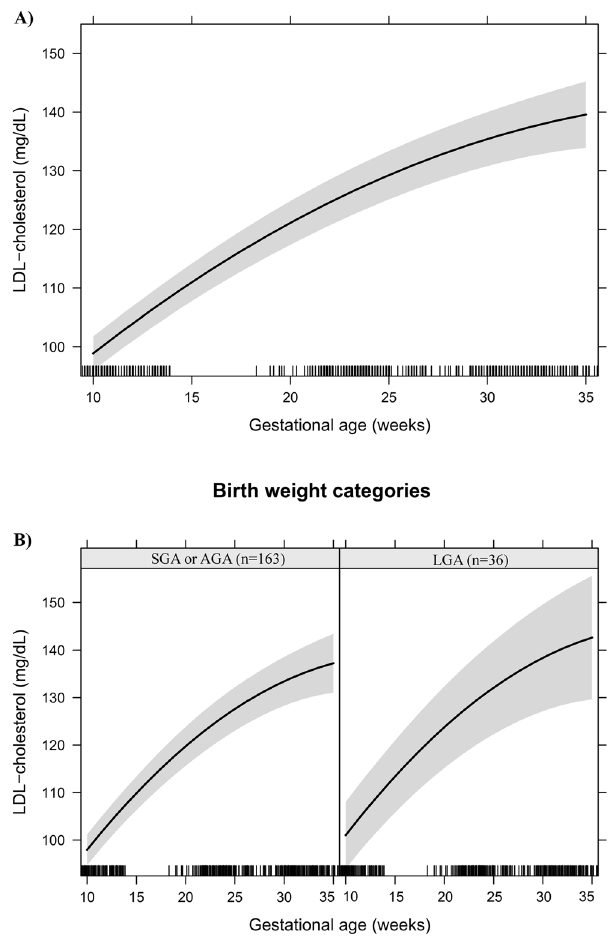
per gestational week according to birth weight categories. Note: The models were adjusted for age, education, smoking habit, pre-pregnancy leisure time physical activity, pre-pregnancy energy intake, glycaemia, parity, early pregnancy BMI, gestational weight gain and quadratic gestational age. Data are presented as linear mixed effect coefficient ( β ) and 95% CI. p-value refers to the maximum likelihood estimator. ( A ) Linear gestational age: β = 3.46 (2.77; 4.14), p < 0.001; Quadratic gestational age: β = − 0.042 ( − 0.06; − 0.02), p < 0.001. ( B ) SGA or AGA - Linear gestational age: β = 3.11 (2.38; 3.83), p < 0.001; quadratic gestational age; β = − 0.03 ( − 0.05; − 0.02), p < 0.001. LGA - Linear gestational age: β = 4.956 (3.30; 6.62), p < 0.001; gestational age; β = − 0.08 ( − 0.12; − 0.04), p <